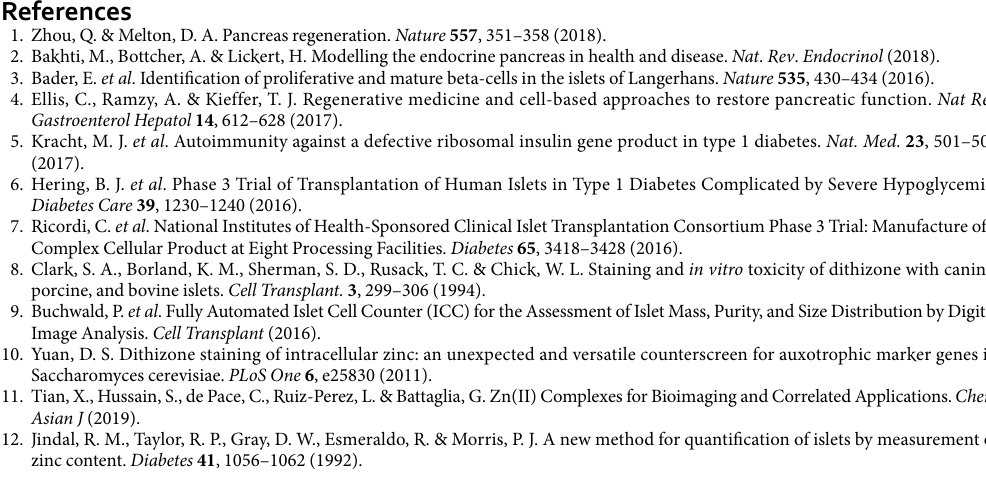
CO 2 on Matrigel-coated plates (BD BioScience, Cat #354671) in mTeSR ™ 1 Complete Kit medium (StemCell Technologies, Vancouver, Canada, Cat #85850) that was changed daily until cells were confluent. Cultured H1 cells were dissociated into single cells by incubation with Accutase (STEMCELL Technologies, Vancouver, Ca., Cat #07920) for 5–10 minutes at 37 °C. Single cells were counted and 5.5 × 10 6 cells in 5.5 mL mTeSR medium sup- plemented with 10 µ M Y27632 (Stemgent, 04-0012-H-10) were seeded into 6-well low-attachment plates (Costar, Cat #3471), placed on an orbital shaker (New Brunswick Innova 2000, #M1190-0000) set to 100 rpm to promote cluster formation and then cultured at 37 °C, 5% CO 2 . Forty-eight hours later, the culture medium was changed into differentiation medium. Stage-specific differentiation was conducted by the controlled addition of specific small molecules as described 28 . At each stage, representative clusters were transferred into new 6-well culture dishes and washed 3 times with 3 mL of COHSII (Gemini, Sacramento, CA, Cat#900-7500) prior to staining with iDTZ. After 3 minutes, the cells were washed 3 times with 3 mL of COHSII and suspended with COHSII. Cell clusters were examined using a ckx31 Olympus microscope and pictures were acquired using a camera. The iDTZ solution employed was a single batch stored at − 20 °C until use. Human islets stained with iDTZ were used as control. Measurement of zinc concentration using iDTZ. ZnCl 2 (Sigma, CAS: 7646-85-7) was dissolved using MQH 2 0 to prepare a concentration of 200 µ M. To test the sensitivity of the iDTZ, 50 μ L aliquots of iDTZ [500 μ M] were pipetted into wells of a black flat-bottom 96-well plate (Corning, Cat #3631) along with a 50 μ L aliquot of nine concentrations of ZnCl 2 (final concentration = 100, 50, 25, 12.5, 6.25, 3.125, 1.56, 0.78, 0 μ M). Control wells contained 50 µ L of 500 µ M of iDTZ and 50 µ L of water served as the blank. Each concentration was rep- licated twelve times. After a 15 minute incubation at room temperature, the plate was read at 570 nm using a Tecan infinite M200 (Tecan Group Ltd, Männedorf, Switzerland) plate reader and a linear standard curve was established.